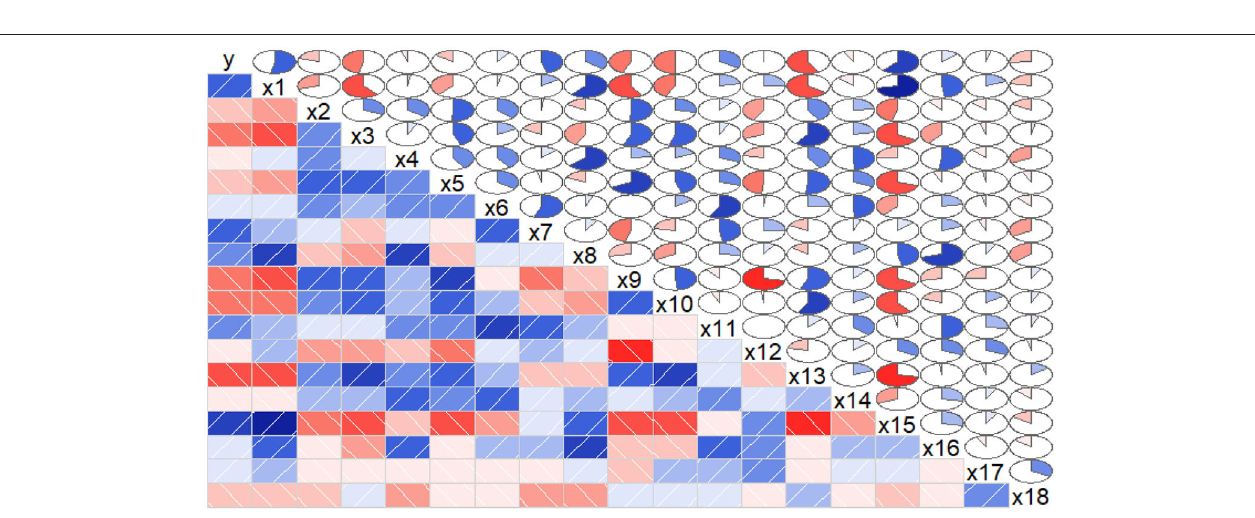
FIGURE 3 | Correlations between the biomass and the physiological/biochemical indicators of S.miltiorrhiza biomass. The blue rectangles represent a positive correlation, the red rectangles represent a negative correlation. The area of the circle represents the degree of correlation. According to correlograms shown in this figure, there were correlations among the biomass and the physiological/biochemical indicators.